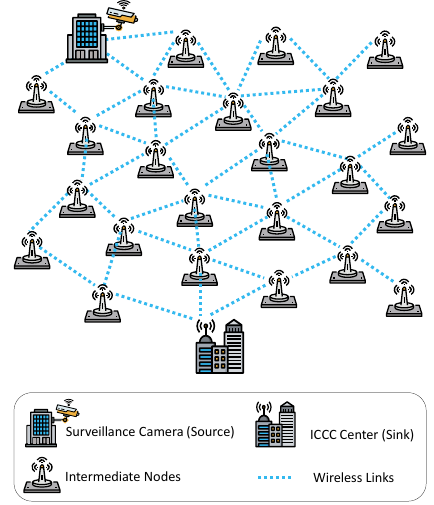
Figure 7. Evaluation network topology.